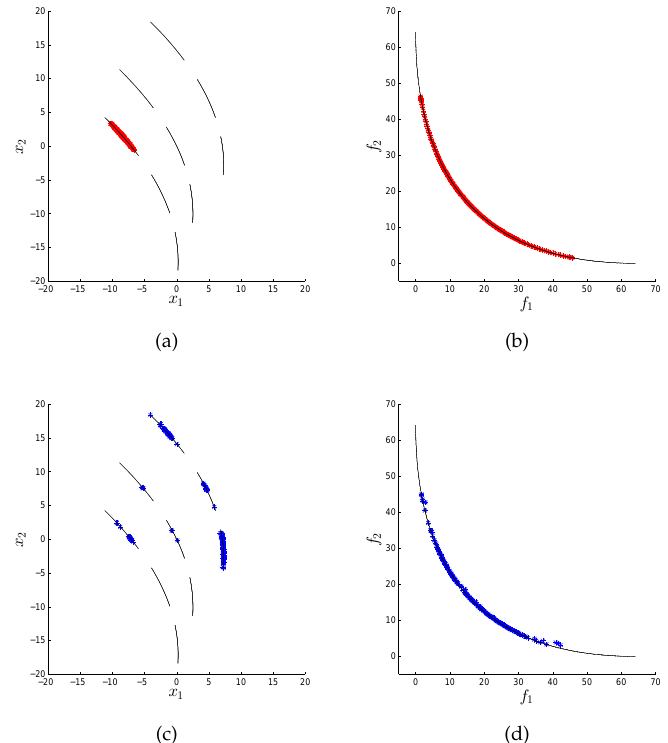
Figure 9. Graphical results of the run with the median values for the RPH3 function for the MOEA/D algorithm. ( a ) Decision Space Original; ( b ) Objective Space Original; ( c ) Decision Space VR; ( d ) Objective Space